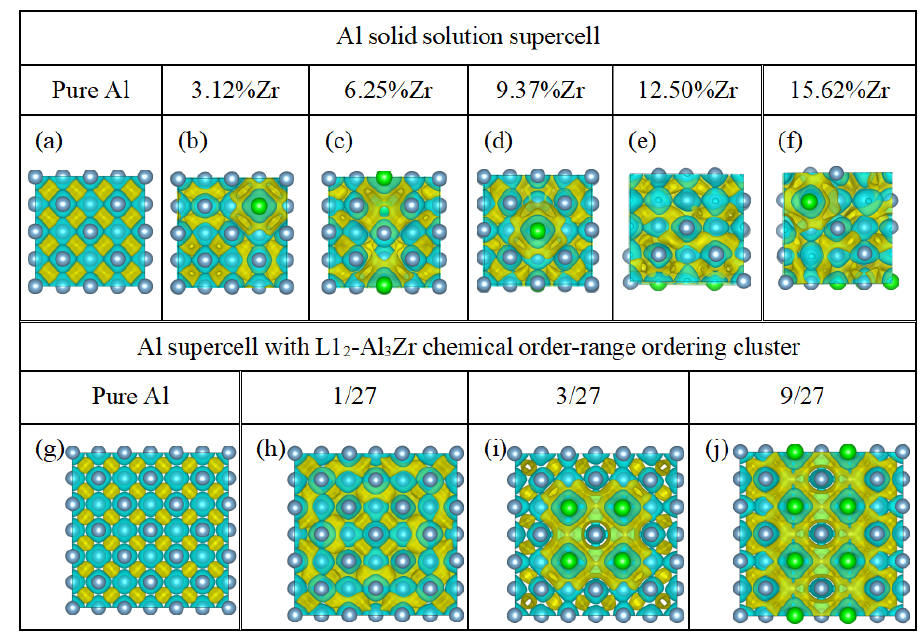
Figure 7. ( a – f ) Deformation charge density of pure Al and Al solid solution with varied compositions of the solute atoms Zr after relaxing atoms and volumes and ( g – j ) deformation charge density of pure Al and the Al supercells with the chemical short ‐ range ordering clusters L1 2 ‐ Al 3 Zr after relaxing atoms and volumes. The isosurface value is set to 0.003 e/Bohr 3 .